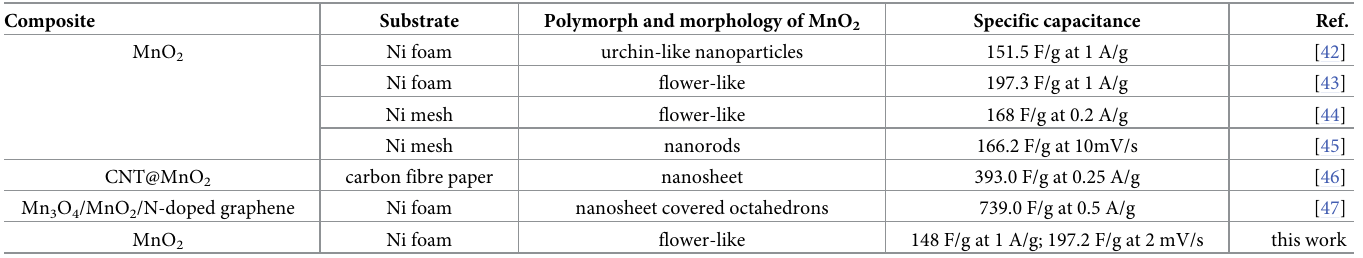
Table 1. Comparison of specific capacitance with other studies on Ni substrate.